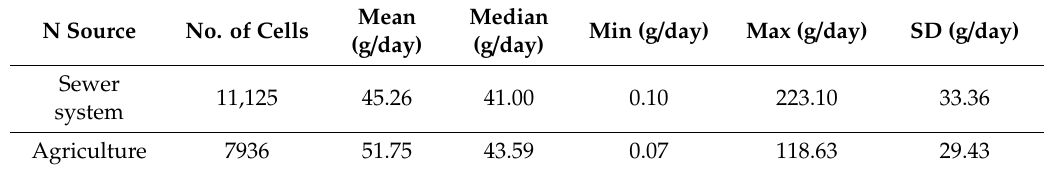
Table 3. Statistics for the estimated nitrogen load expressed in g / day per 50 m cell.